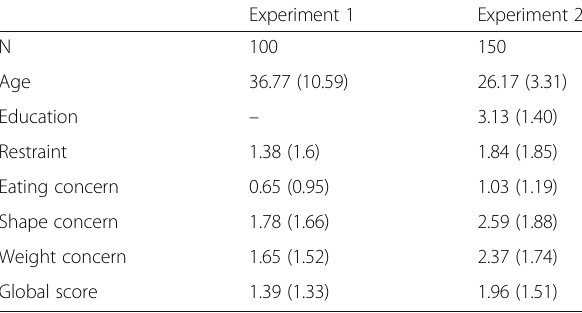
Table 3 Person-level covariates in Experiments 1 and 2, with means and standard deviations by participants in parentheses